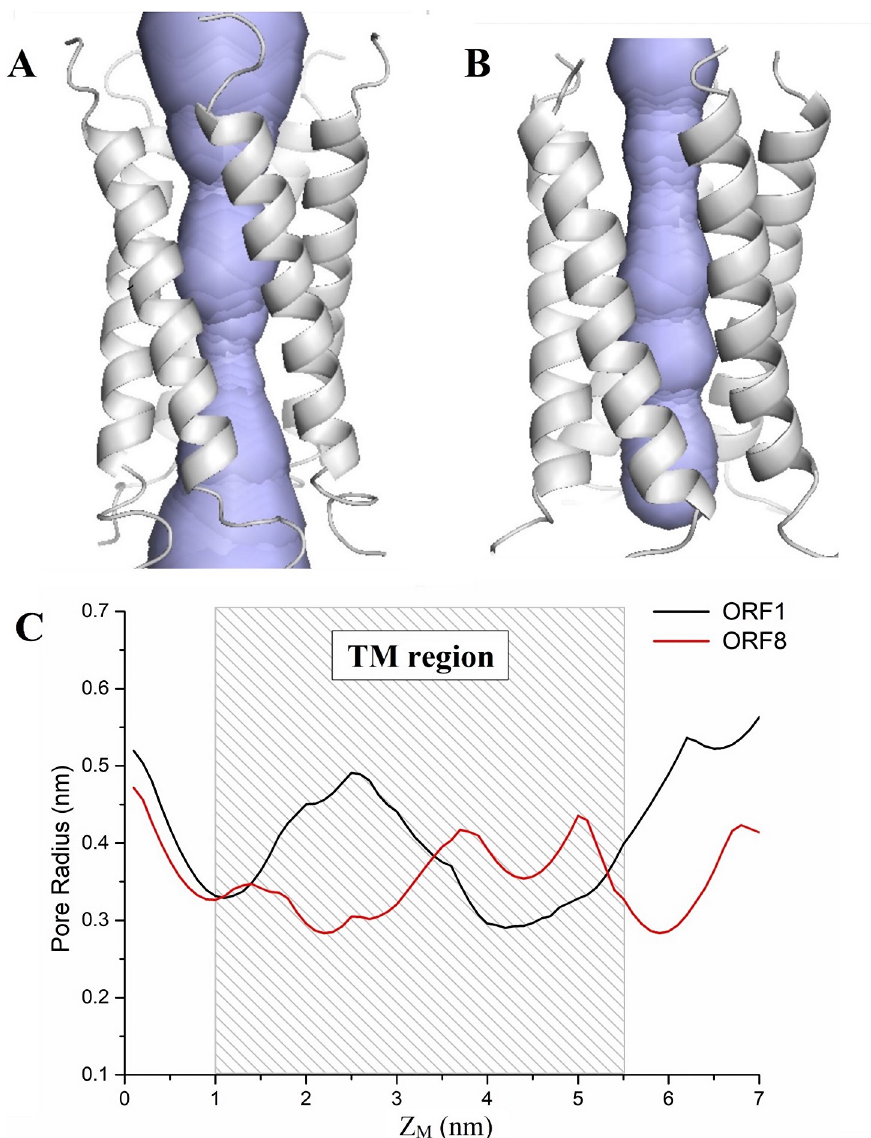
Fig 6. Channel structures in the ORF1 (A) and ORF8 (B) with the pore’s lining surfaces. The variation in the inner pore radius of ORF1 (black) and ORF8 (red) is shown in (C). The Z M shows the distance from the center of mass, and the rectangle with a sparse pattern in (C) is the TM region of the pore. The calculated channel was measured using CAVER 3.01